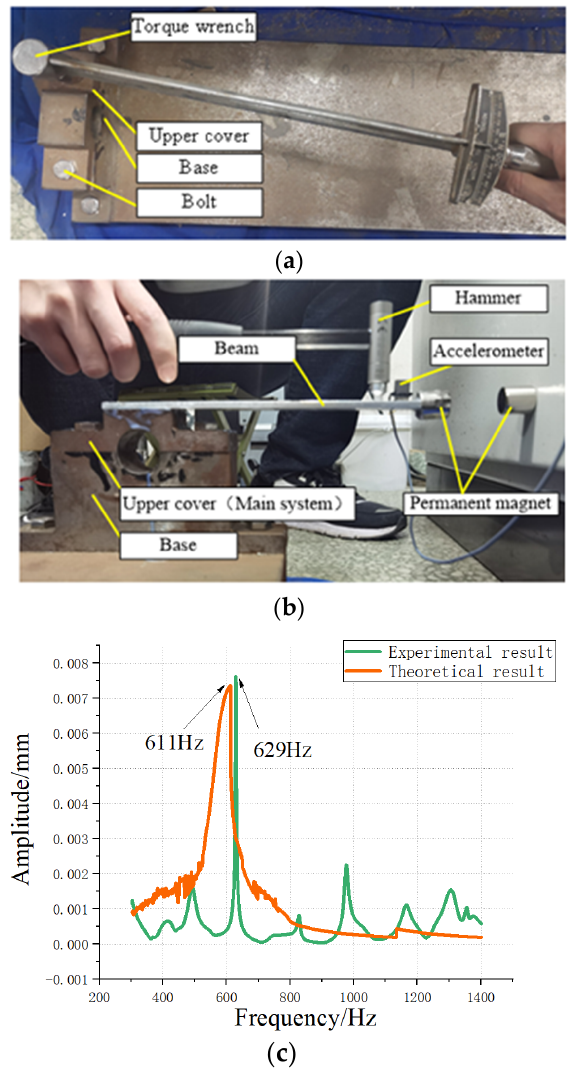
Figure 3. Experimental process. ( a ) Pretighting torque adjustment; ( b ) Dynamic test of experimental setup; ( c ) Experimental result.